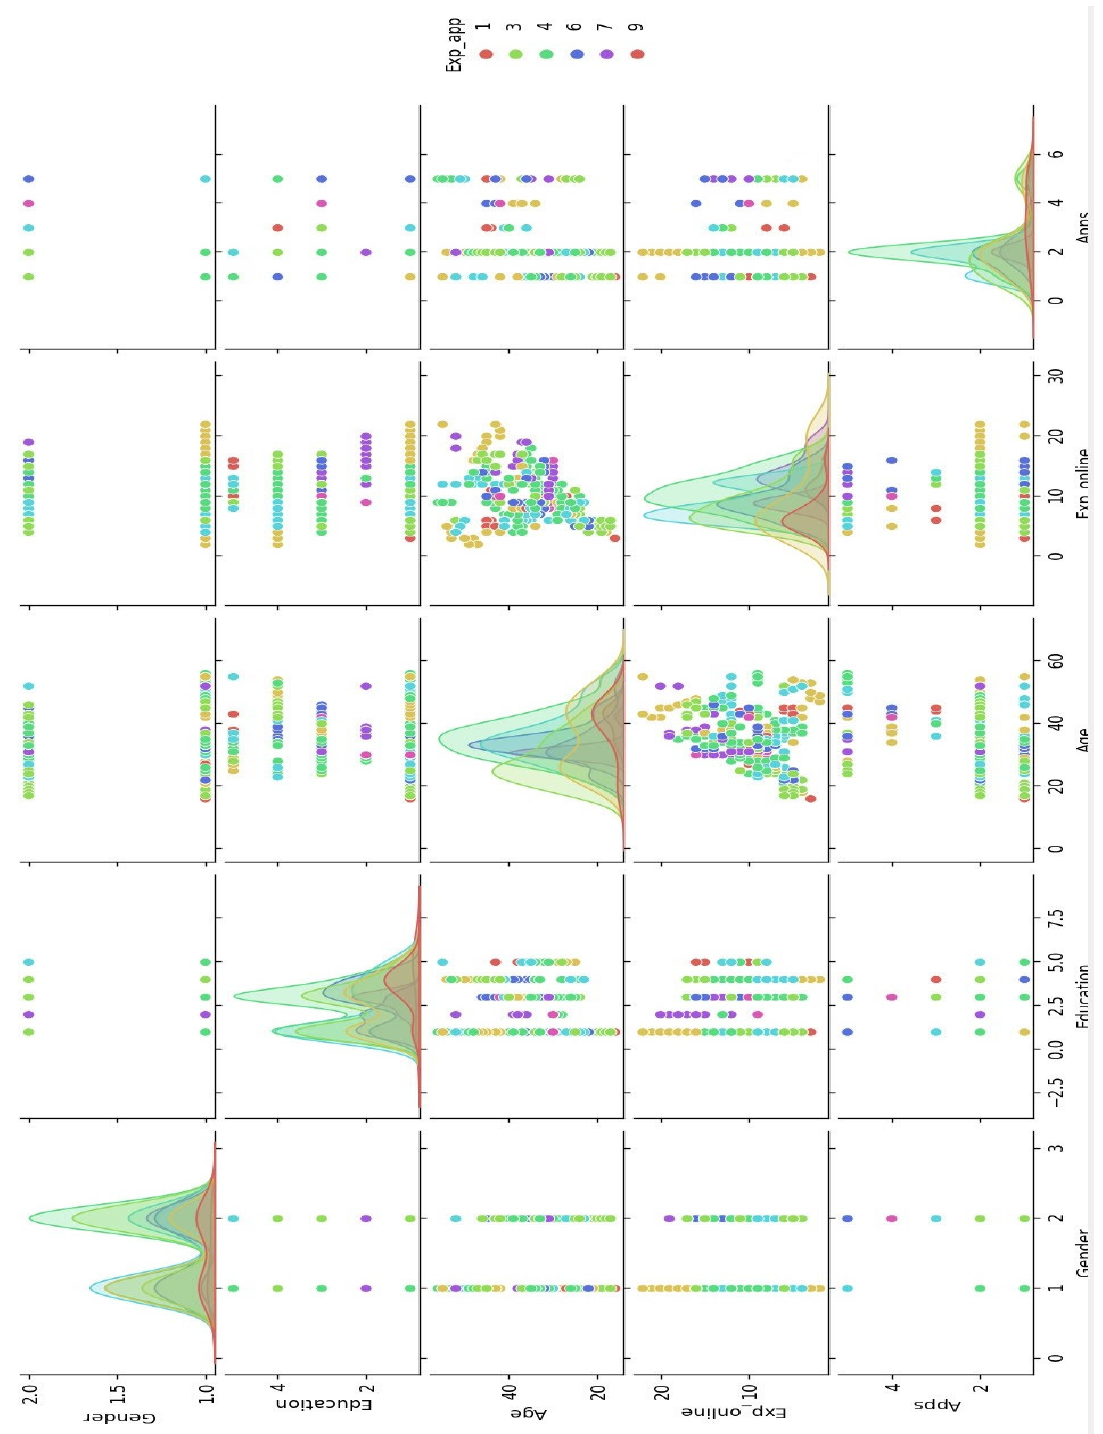
Figure 2. The pair plot of the respondents’ demographic data in Hungary (source: authors’ calcu- lations based on Python programming; Seaborn package; VS Code